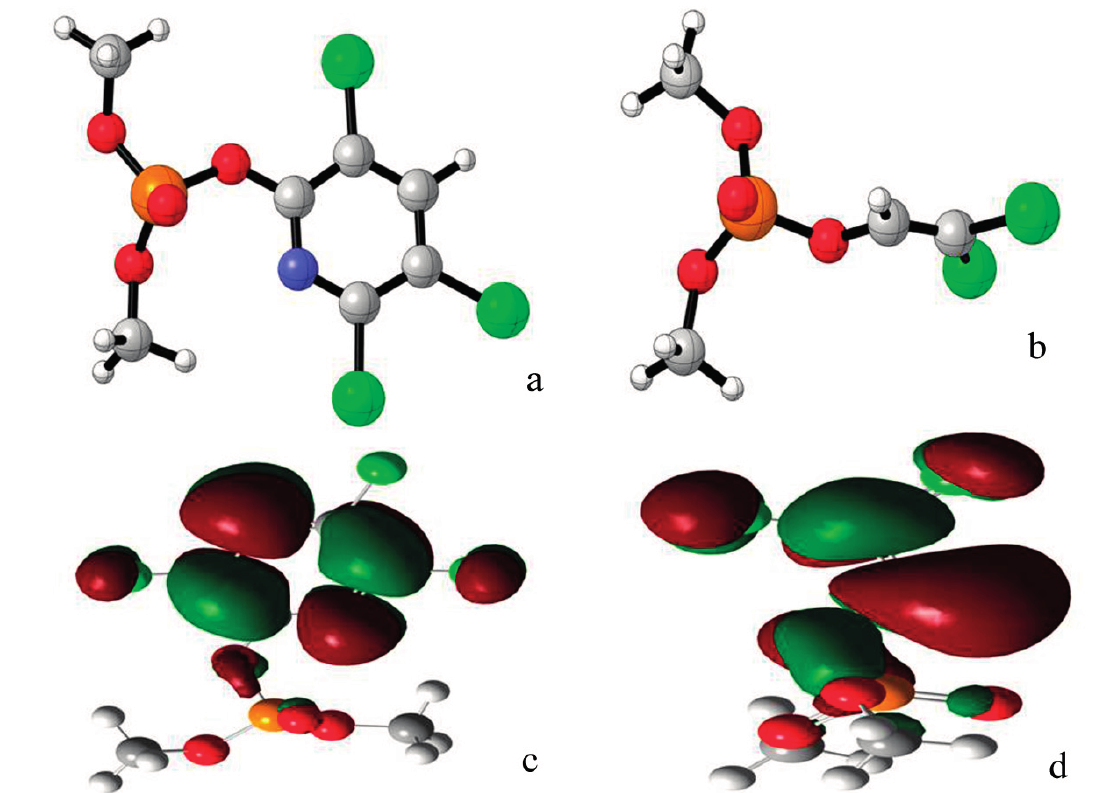
Figure 3. Chemical structure of ( a ) Chlorpyrifosmethyl oxon; ( b ) Dichlorvos generated by CLY view v1.0.561 beta; ( c ) The LUMO orbit of chlorpyrifosmethyl oxon; and ( d ) The LUMO orbit of dichlorvos generated by Gaussian View